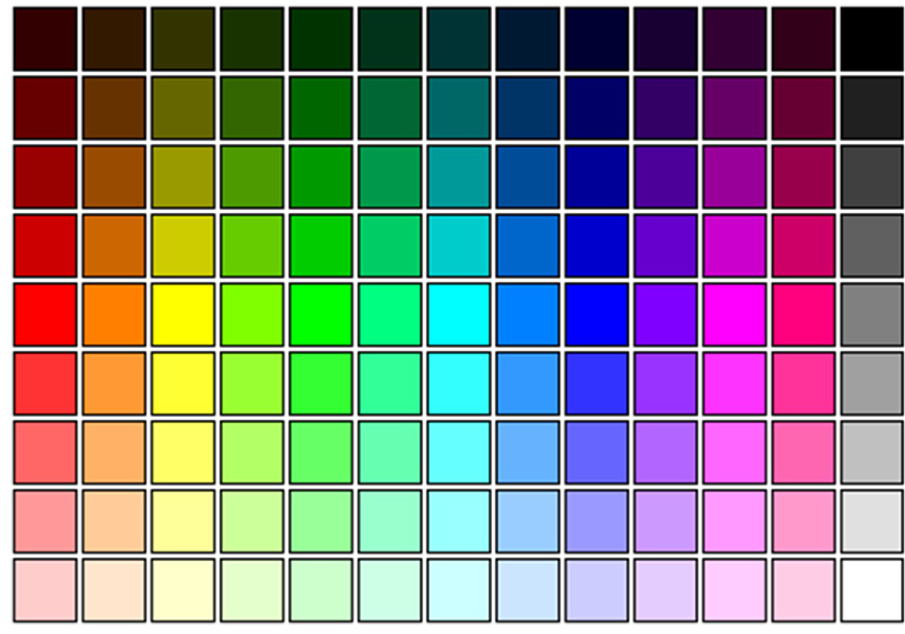
Fig 2. RGB color model as 9 × 13 matrix M . White is located at the right bottom cell; the blue color, columns 7–9, does not occur in our orchids. RGB encoding. We use the RGB (Red Green Blue) color space as a foundation for the color labeling as this color model is also used in the description of the digital images of orchids. RGB color labeling was applied to the color labeling of CF and CL. As the RGB color model